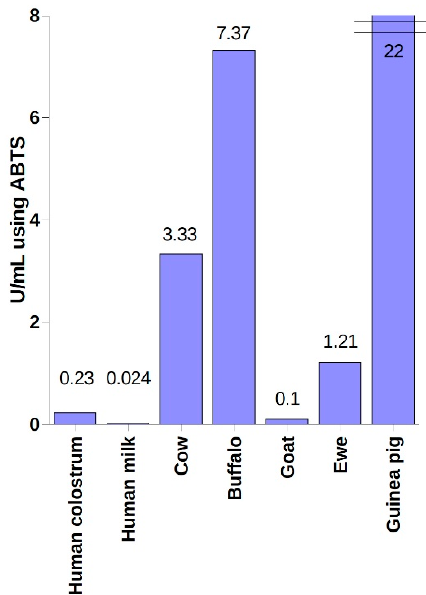
Figure 1. Activity of lactoperoxidase (LPO) in human milk and colostrum [35], milk of cows [64], buffalos [65], goats [66], sheep [67], and guinea pigs [69]. Comparison of LPO activity studies conducted by different teams may be problematic and subject to error due to the lack of standardization of the conditions of the analysis and the applied unit of activity.